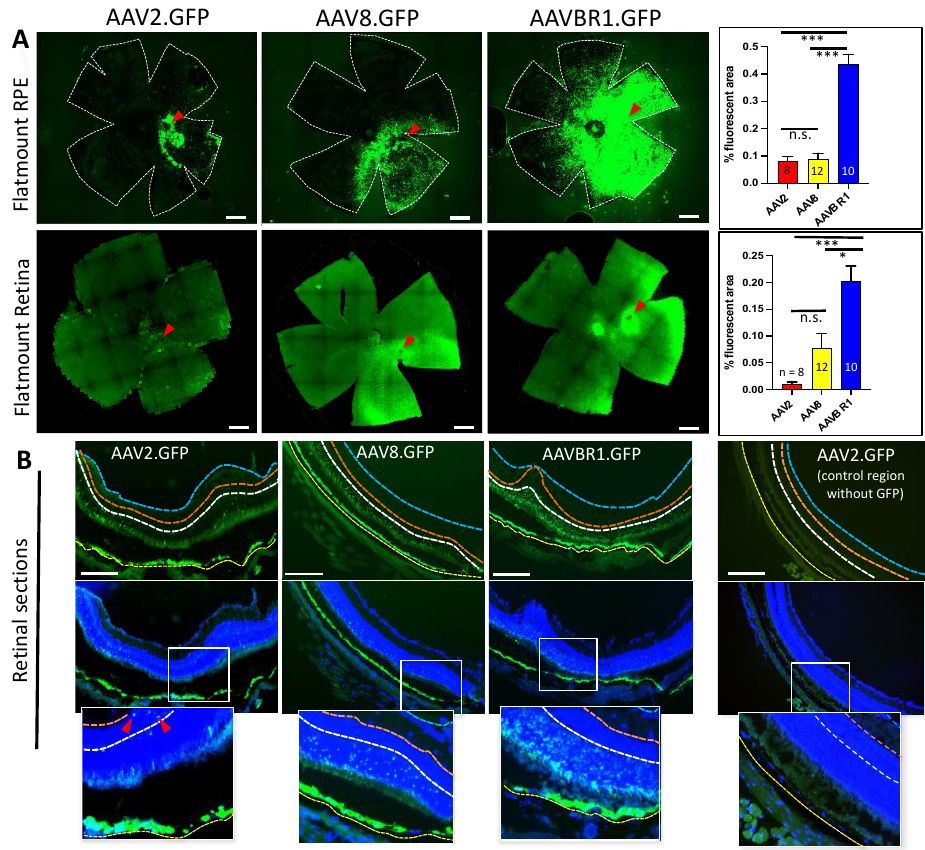
Figure 3. Six-week post-injection comparison of GFP signal following subretinal injection of 5 × 10 8 vg AAV2, AAV8, or AAVBR1. ( A ). Top panels show representative images and corresponding bar graphs of average % fluorescent area in RPE. Bottom panels are retinal images with corresponding bar graphs from the same eye as RPE panels above. Numbers of eyes examined are indicated in graphs (scale bar = 500 μ m, error bars represent SEM, p < 0.001 ***; p < 0.05 *). Red arrowheads show approximate injection sites. ( B ). Sections of AAV.GFP retina/RPE with and without DAPI nuclear stain. Considerable disparity in AAV2, AAV8, and AAVBR1 tropism for retina is apparent even in sections with nearly uniform GFP signal in underlying RPE. A section without GFP signal from the AAV2.GFP-injected eye is shown for comparison. Location of insets is indicated by white outlined rectangles. Red arrowheads point to GFP-positive cells within the inner nuclear layer of the AAV2-injected eye. Yellow, white, orange, and blue dotted lines indicate basal boundaries of RPE, outer plexiform layer (OPL), inner plexiform layer (IPL), and nerve fiber layer (NFL), respectively (scale bar = 200 µ